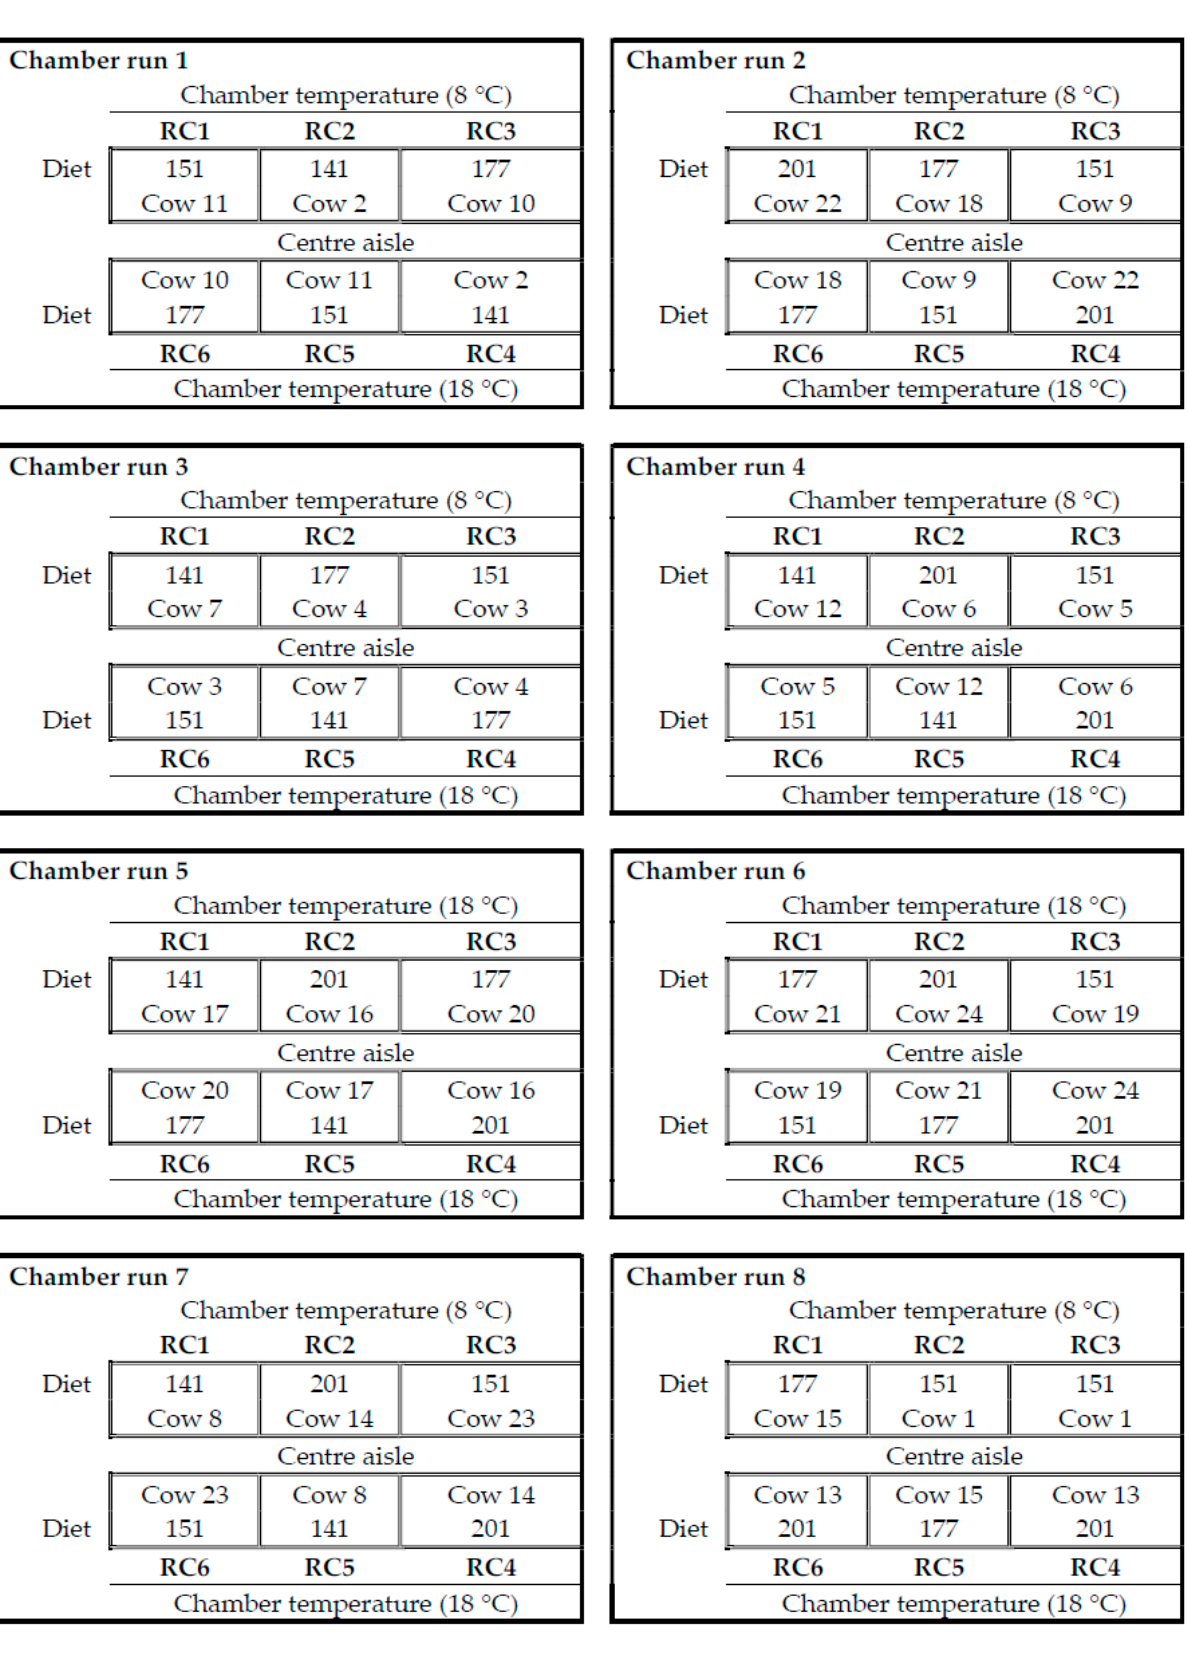
Figure 1. Layout of the allocation of slurry sub-samples of the 24 cows (from cow 1 to cow 24) to the 6 open-circuit respiration chambers (from RC1 to RC6).